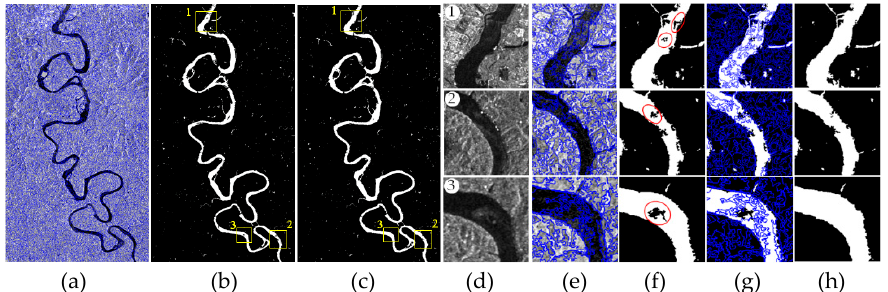
Figure 10. Classification refinement of TRS_LM_RGA-based result using the VV image. ( a ) multiresolution segmentation result of the VV image with scale = 70, shape = 0.1, and compactness = 0.5; ( b ) TRS_LM_RG-based result without classification refinement; ( c ) TRS_LM_RGA-based result with classification refinement; ( d ) zoomed ROIs in ( c ); ( e ) segmentation results; ( f ) flood maps without refinement; ( g ) segmentation overlaid on the flood maps without refinement; ( h ) flood maps after refinement.